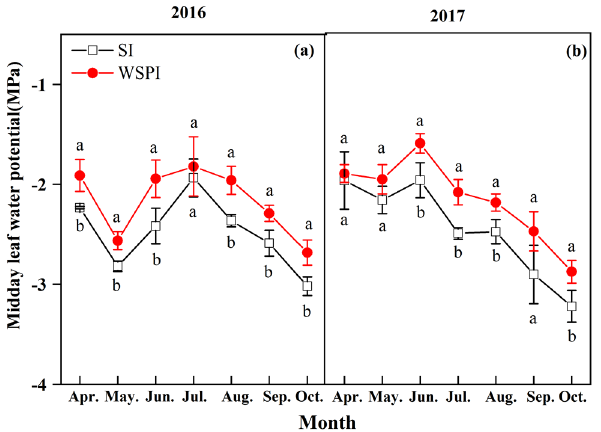
Figure 4. Seasonal course of midday leaf water potential under water storage pit irrigation (WSPI red line) and surface irrigation (SI, black line) in 2016 ( a ) and 2017 ( b ). Bars indicate standard deviation of the mean ( n = 3); the same letters in figure indicate nonsignificant differences between the treatments, whereas different letters show significant differences ( p < 0.05).